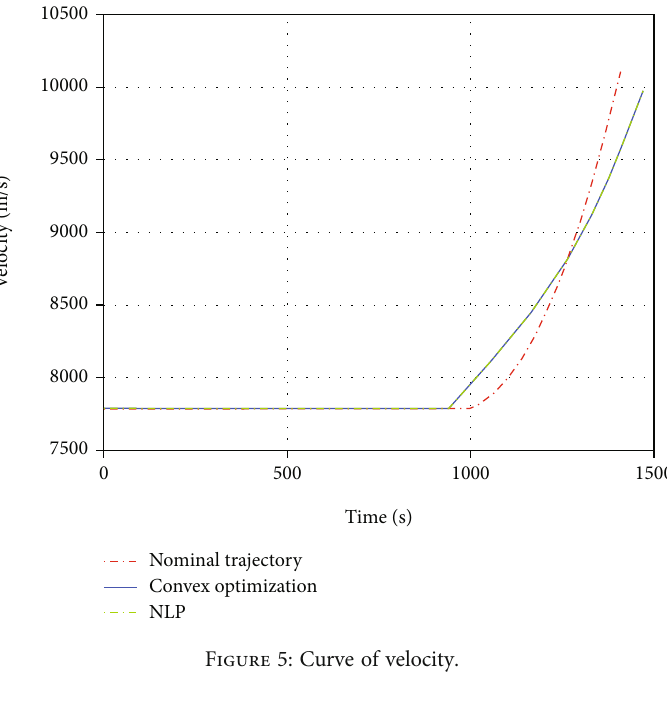
Figure 5: Curve of velocity.